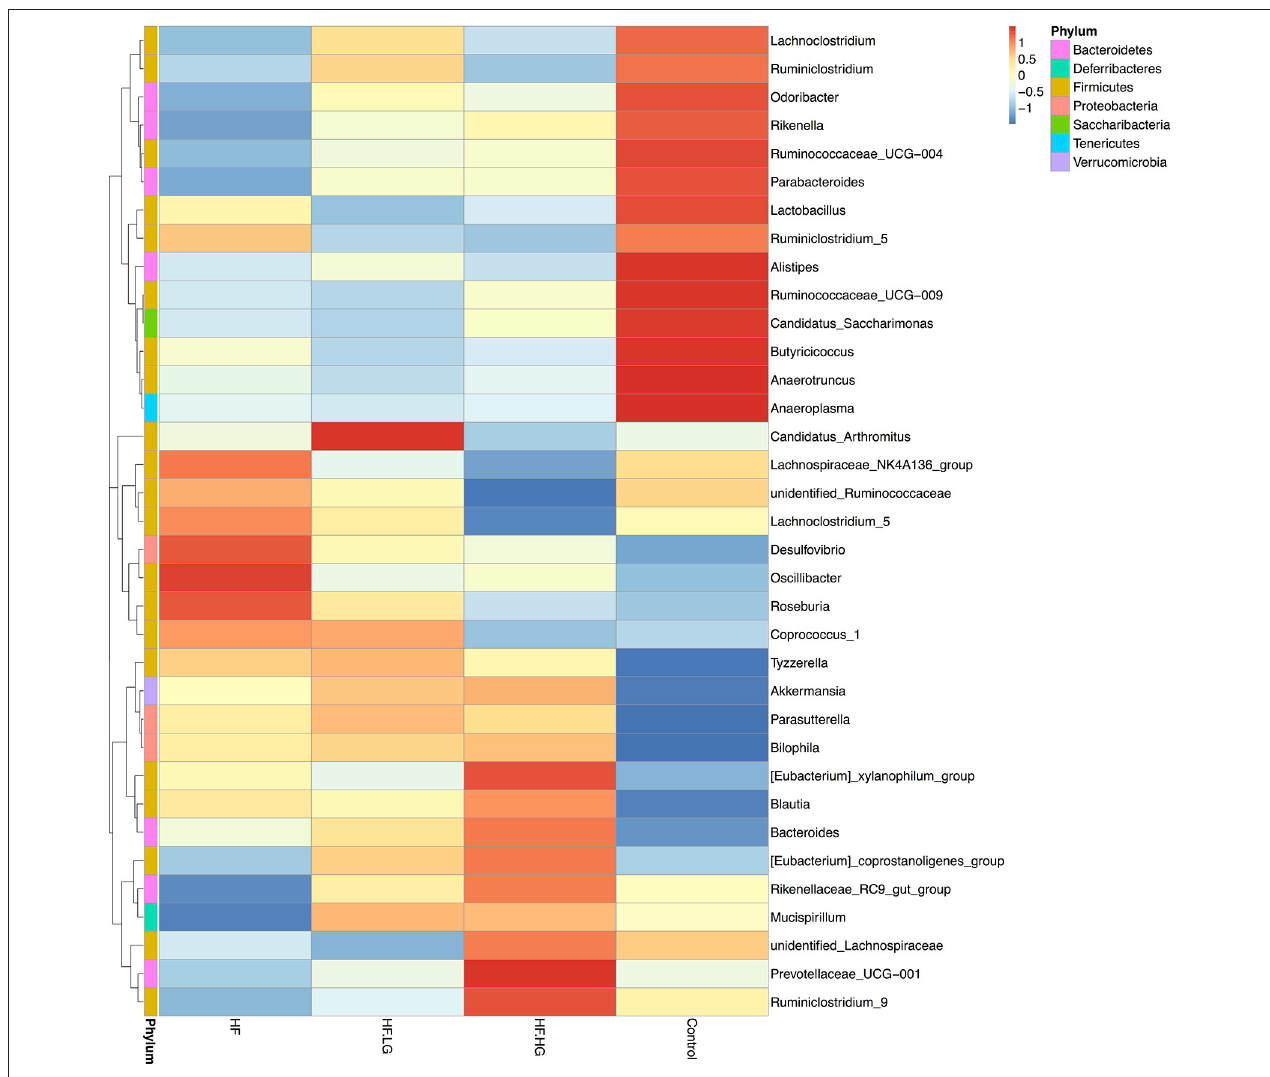
FIGURE 5 | Heat map analyses of abundant genera in each group ( n = 6–8/group). HF, high-fat diet without genistein; HF. LG, high-fat diet with low-dose genistein; HF. HG, high-fat diet with high-dose genistein; Control, normal control